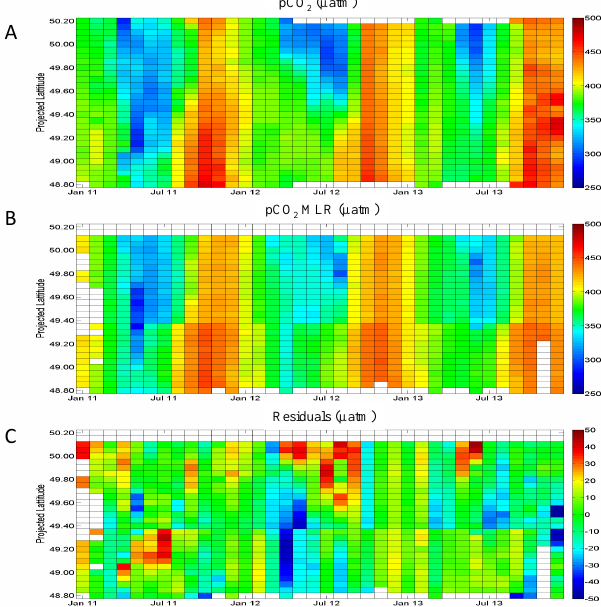
Figure 5. Distribution of monthly gridded (a) p CO 2 (µatm) based on bimonthly DIC/TA measurements (January 2011 to March 2012) and on high-frequency p CO 2 measurements (April 2012 to De- cember 2013) in WEC, (b) p CO 2 ,MLR (µatm) computed from nWEC and sWEC algorithms and (c) residuals ( p CO 2 – p CO 2,MLR in µatm) between Roscoff and Plymouth from January 2011 to De- cember